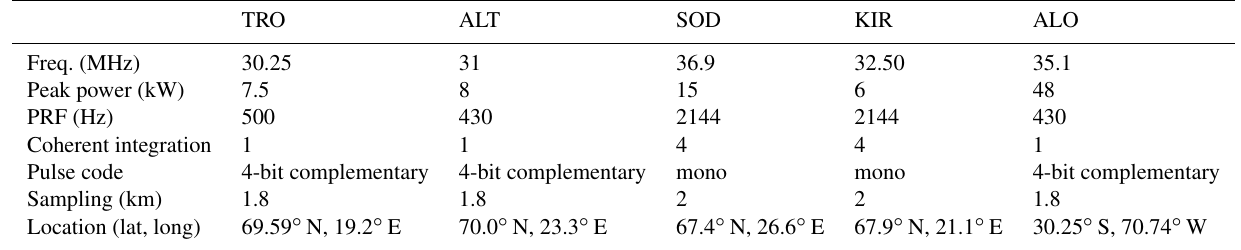
Pulse code 4-bit complementary 4-bit complementary mono Location (lat, long) 69.59 ◦ N, 19.2 ◦